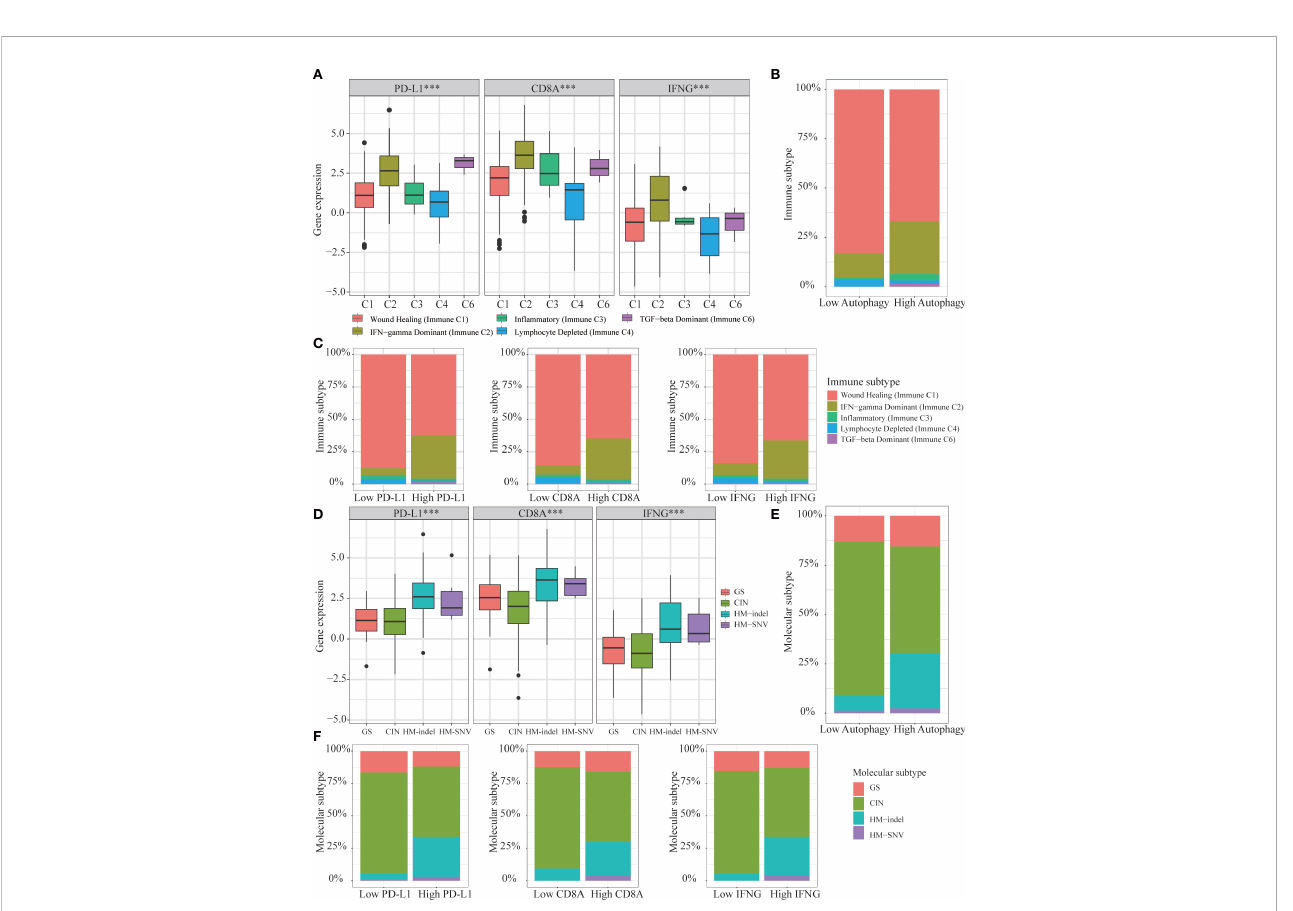
FIGURE 15 Correlation of autophagy score, IFNG, PD-L1 and CD8A expression with 5 immune subtypes and 4 molecular subtypes in TCGA-COAD. (A) In immune C2 and C6, expression of IFNG, PD-L1 and CD8A were consistent and higher. (B, C) In high group of autophagy score, PD-L1, CD8A, and IFNG expression, proportions of immune C2 and C6 were higher. (D) In HM-indel and HM-SNV, expression of IFNG, PD-L1 and CD8A were consistent and higher. (E, F) In high group of autophagy score, PD-L1, CD8A, and IFNG, proportions of HM-indel and HM-SNV were higher.